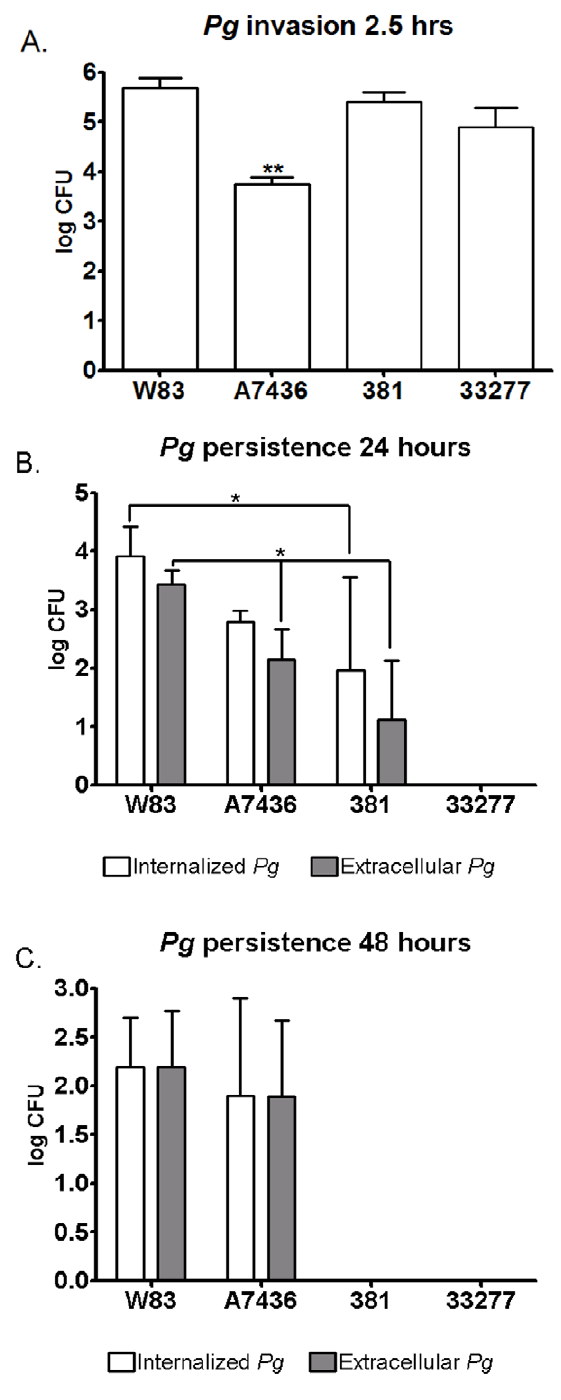
Figure 2. Invasion and persistence of P.gingivalis in HCAE cells. Values represent mean log CFU 6 SD of six biological replicates from two independent experiments. **Values were significantly different from other groups ( P , 0.0001). * Values were significantly different ( P , 0.05).